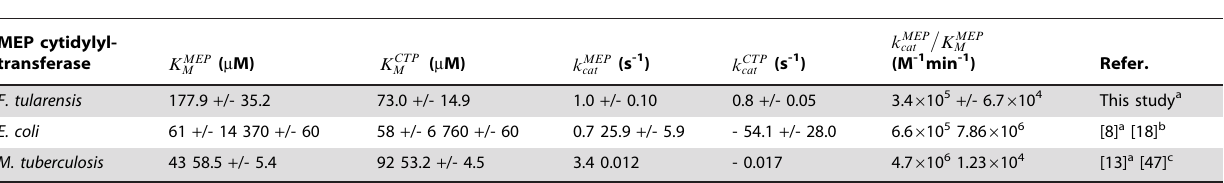
Table 1. MEP cytidylyltransferase Apparent Kinetic Parameters.